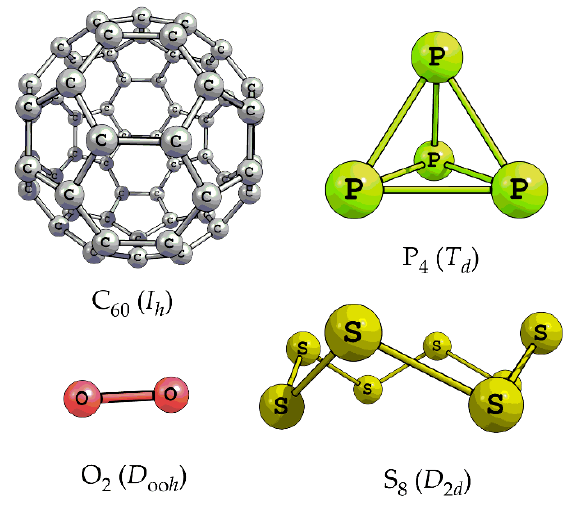
Fig. 1. Zero- h molecules. The point symmetry groups are shown in parentheses.